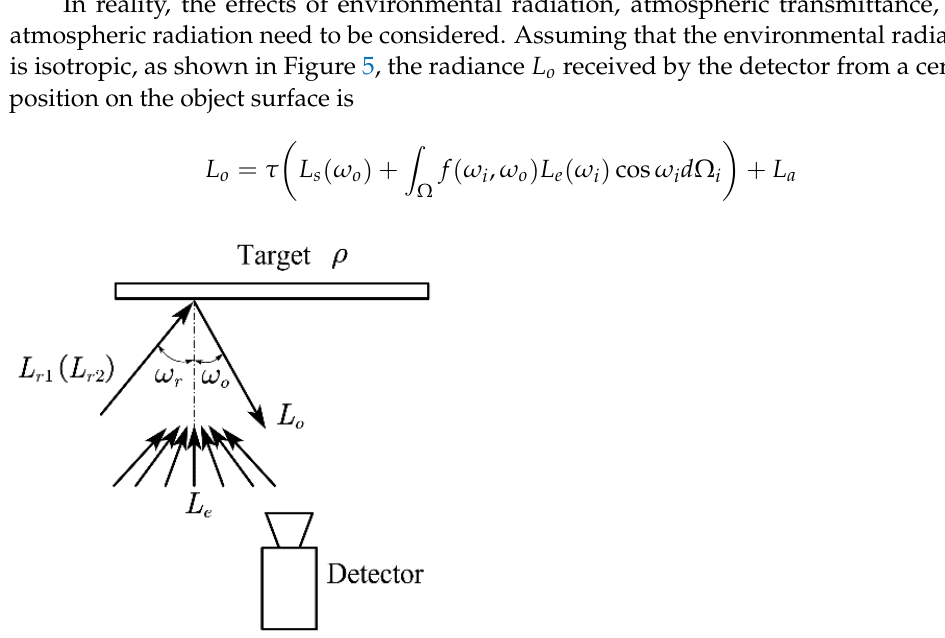
Figure 4. Radiation received by the detector from a planar object.